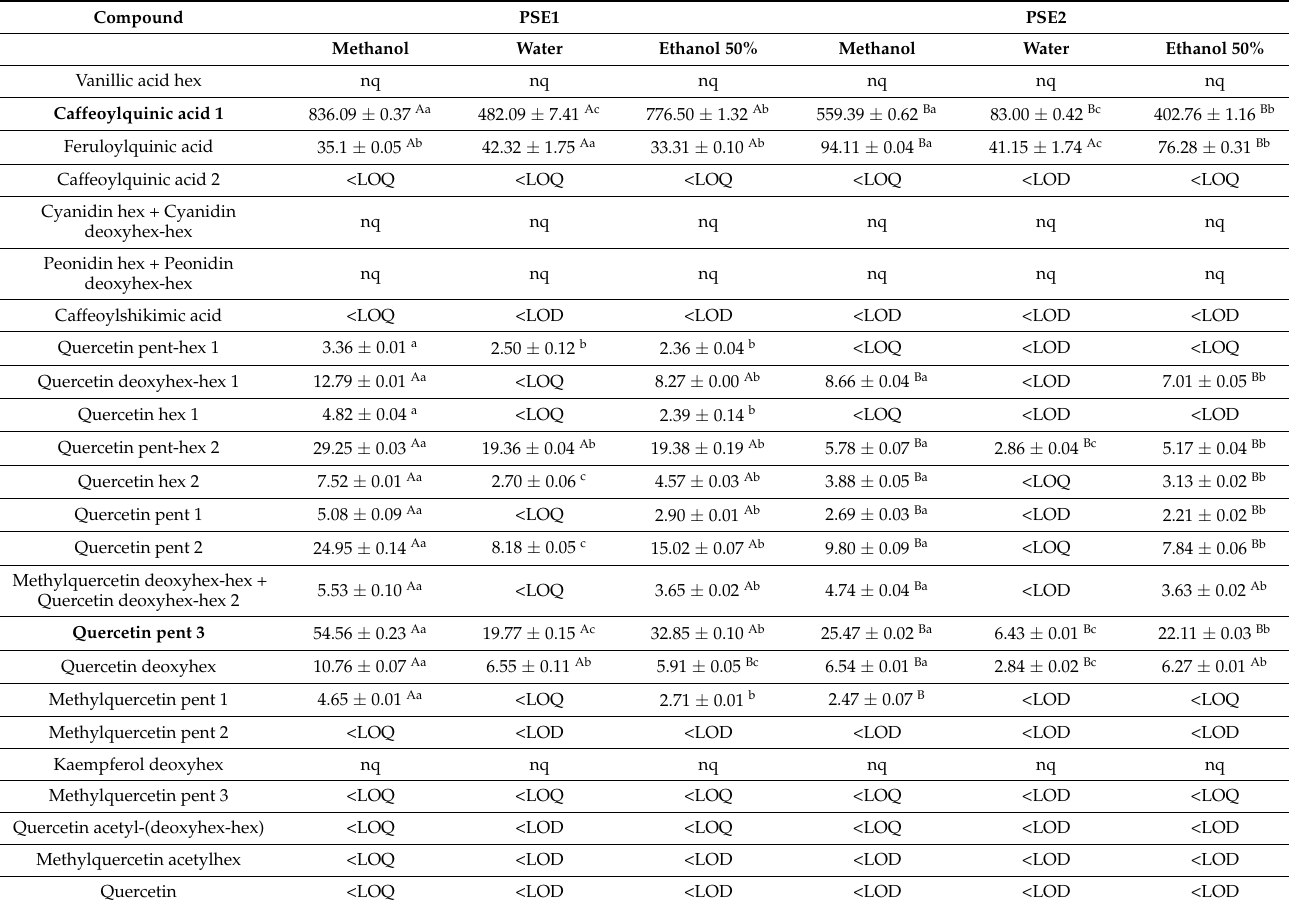
Table 2. Contents (mg/100 g) of phenols in blackthorn fruit